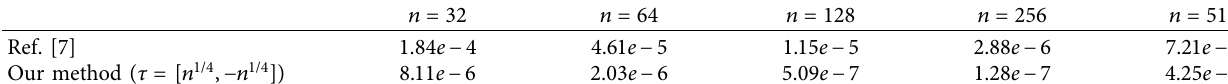
in solving (72) with the exponential spline difference method. ∞